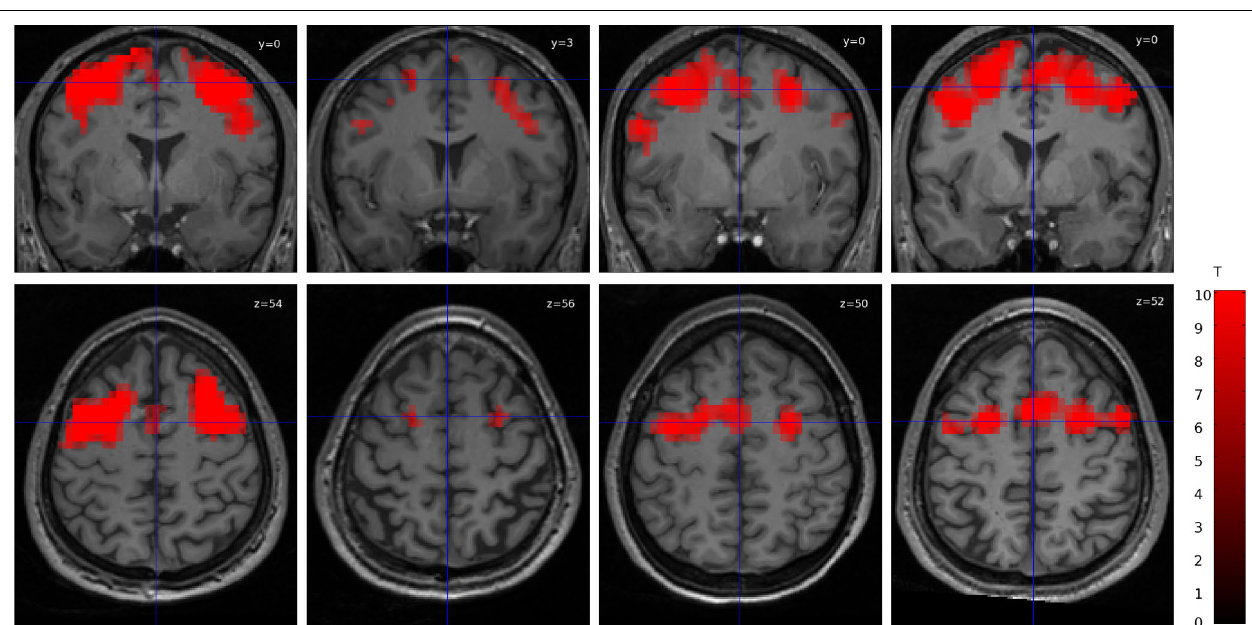
FIGURE 2 | FEF activation t-map for the ‘localizer’ task in four individual participants at threshold t > 3, overlaid on their T1-weighted structural scan, in a coronal (upper panels) and axial (lower panels) view. Only the clusters of activated voxels are shown that overlap with known locations of the